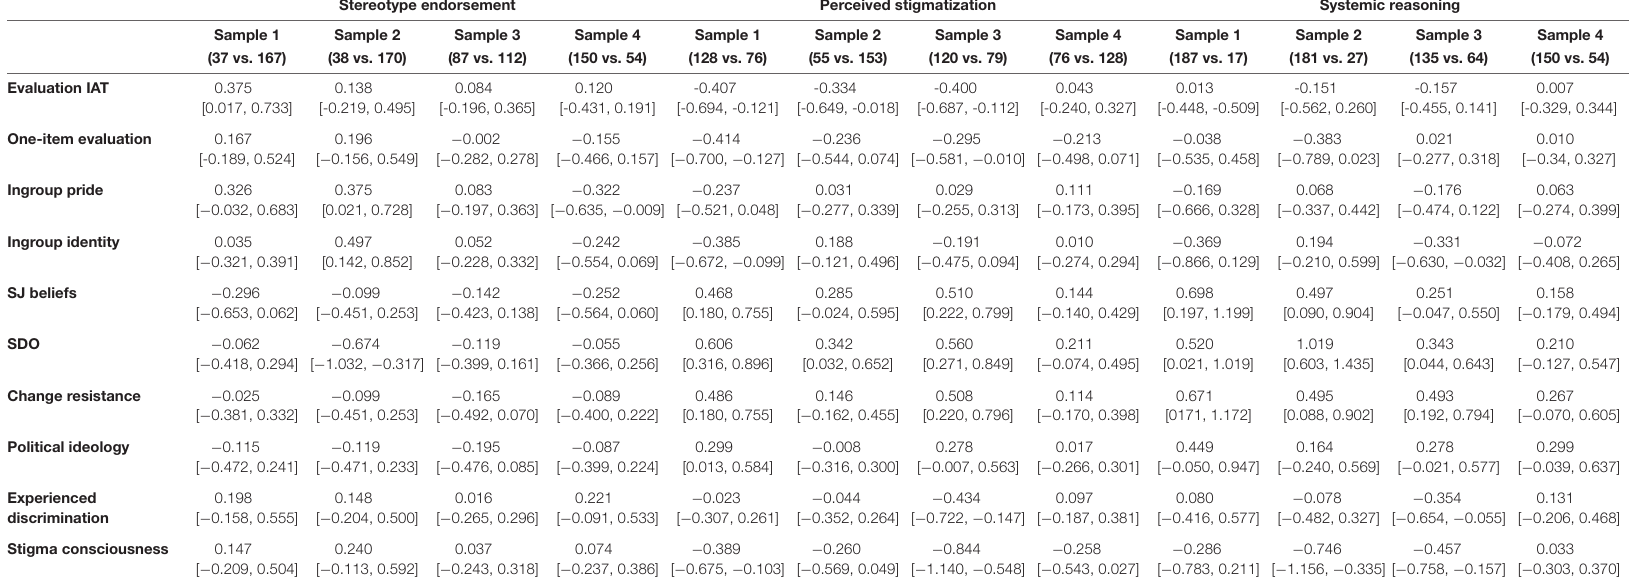
TABLE 6 | Group comparisons reported as Cohen’s d [95%